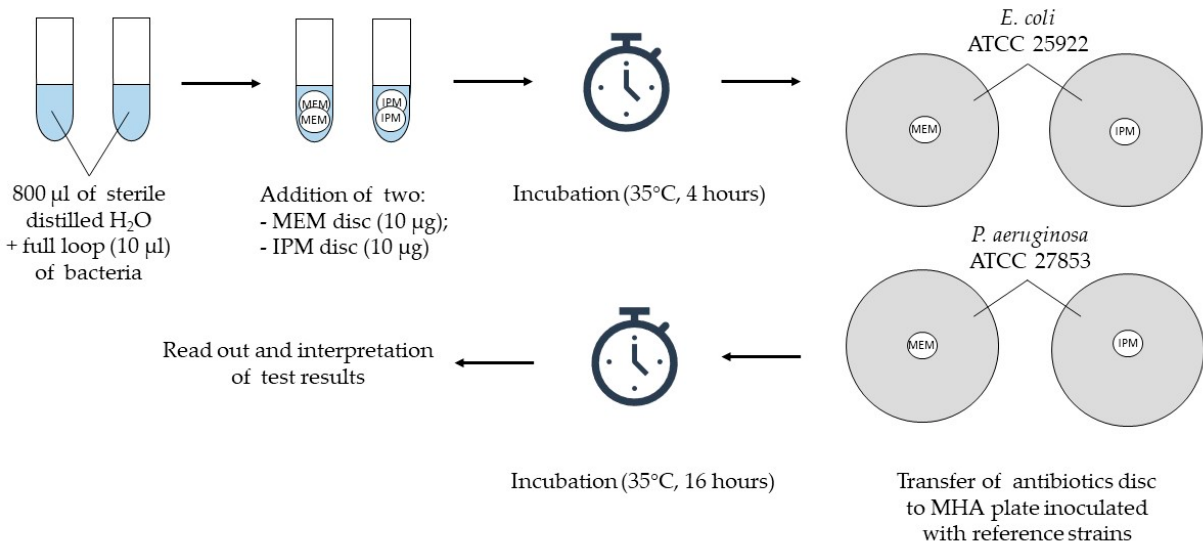
Figure 1. Project design of the primary version of CIM and its modification; ATCC—American Type Culture Collection, IPM—imipenem, MEM—meropenem, MHA—Mueller–Hinton agar.